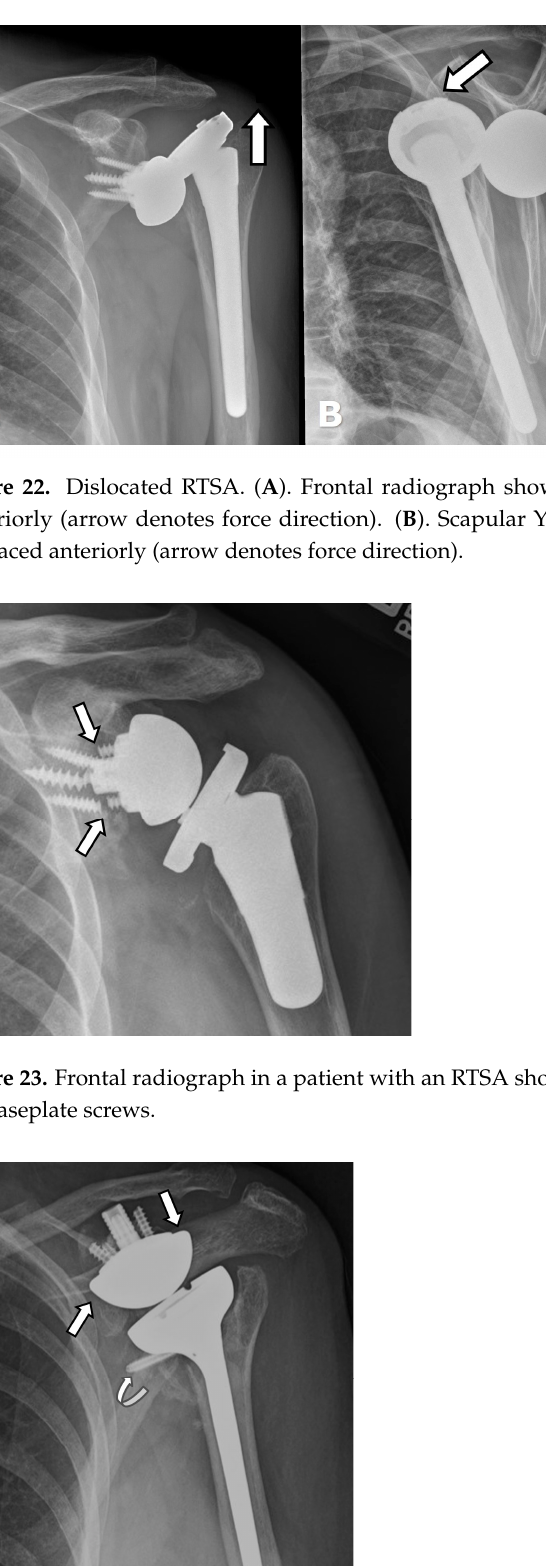
Figure 24. Frontal radiograph in a patient with RTSA shows fracture/break of a screw (curved arrow) as well as superior migration and rotation of the baseplate/metaglene (arrows), now dissociated from the glenoid.